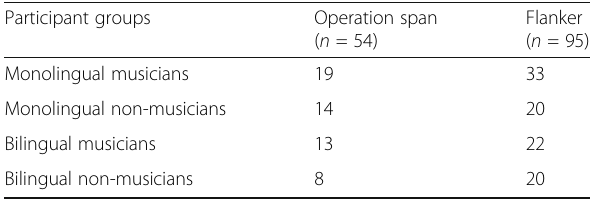
Table 4 Breakdown of sample size for the operation span and flanker tasks Participant